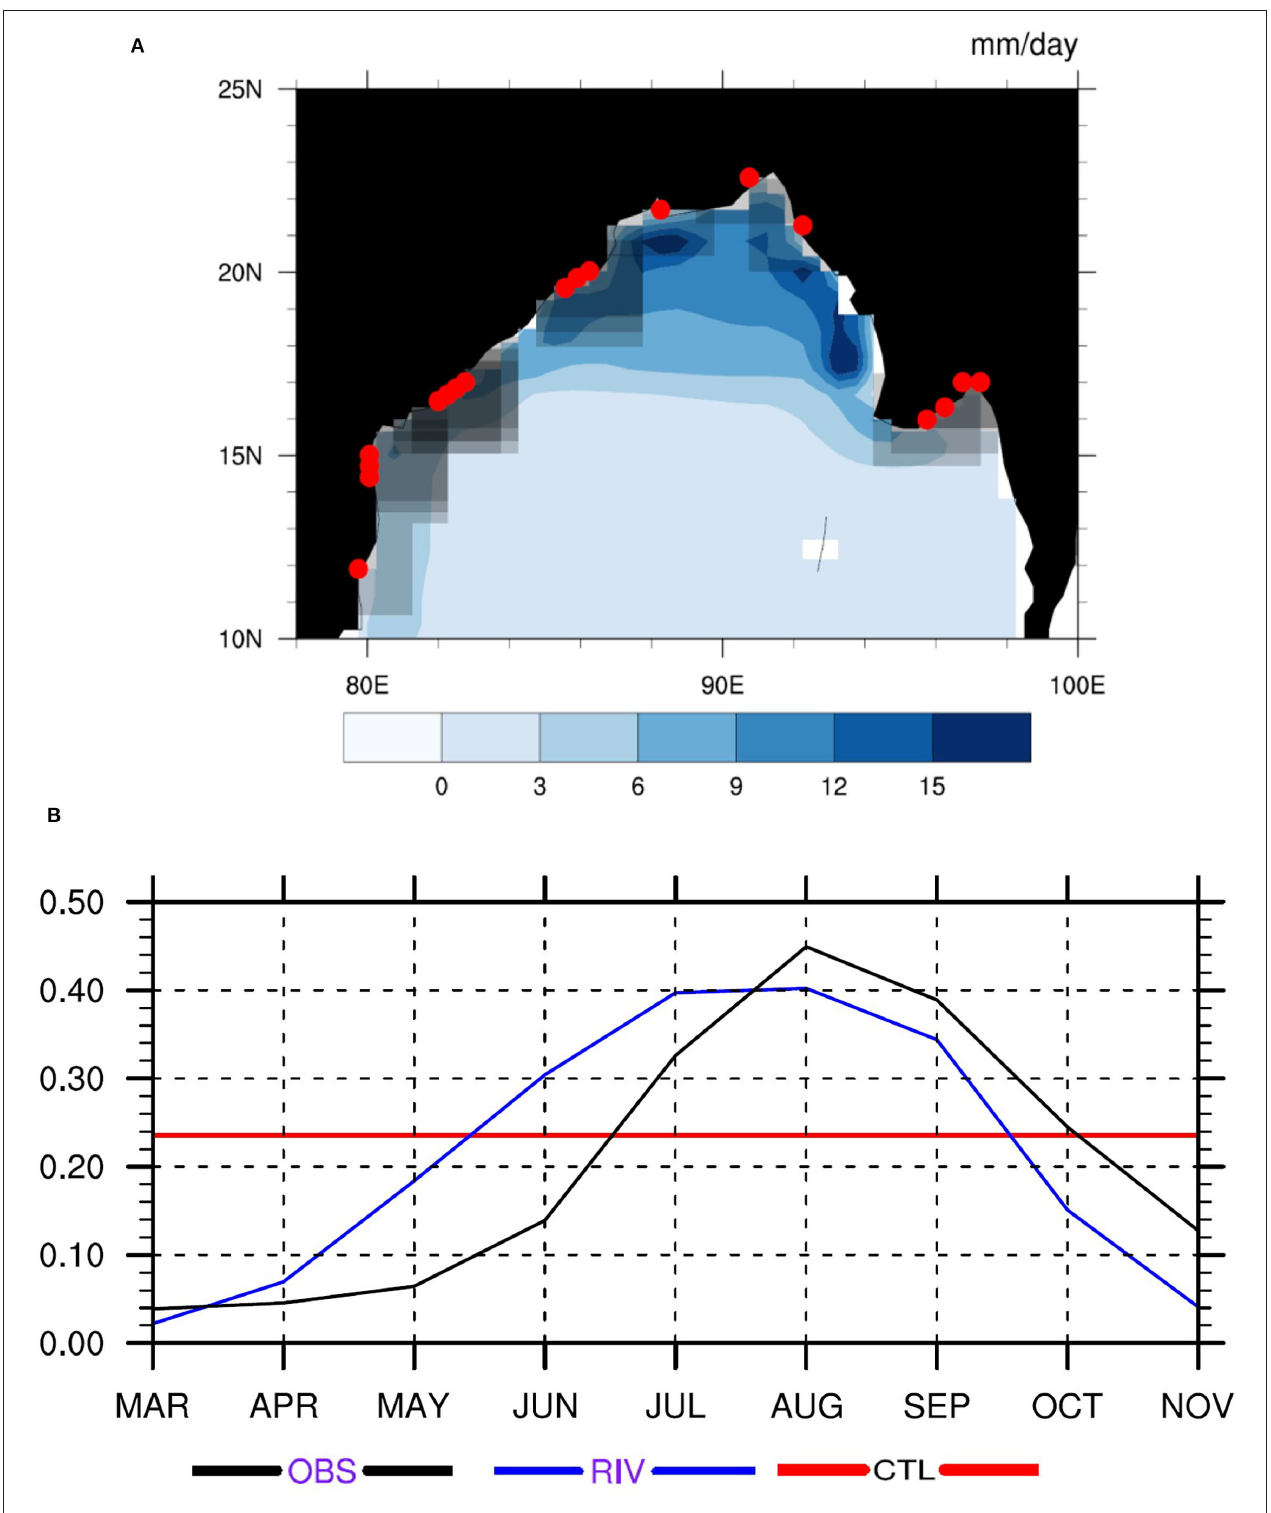
FIGURE 2 | (A) Climatological annual mean values of river runoff (mm day − 1 ) prescribed in the CTL run (shading). The runoff values are pre-spread over the basin before passing them to the ocean model. The red markers denote the river discharge points in the RIV run, and the gray halo around them depicts the area over which the discharge is spread in the ocean model for the RIV run. (B) Climatological annual cycle of river freshwater input ( × 10 4 kg m − 2 s − 1 ) into the northern Bay of Bengal (10 ◦ N-25 ◦ N, 78 ◦ E-98 ◦ E) basin from the Large and Yeager (2009) dataset (black), the annual mean discharge prescribed in the CTL run (red), and the discharge simulated by the RIV run